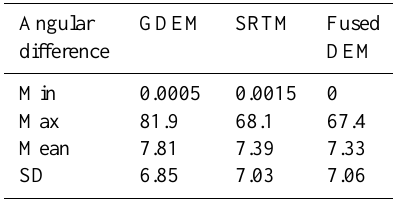
Table 8. Result of angular difference of unit NVs between the global DEMs, fused DEM and reference DEM. Angular GDEM SRTM Fused difference DEM Min 0.0005 0.0015 0 Max 81.9 68.1 67.4 Mean 7.81 7.39 7.33 SD 6.85 7.03